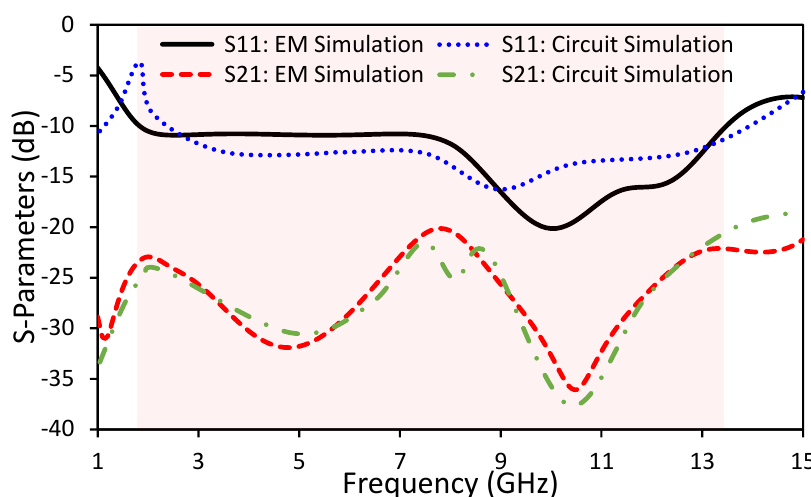
Figure 7. Lumped element equivalent circuit simulation comparison with EM simulation in the presence of decoupling structure.